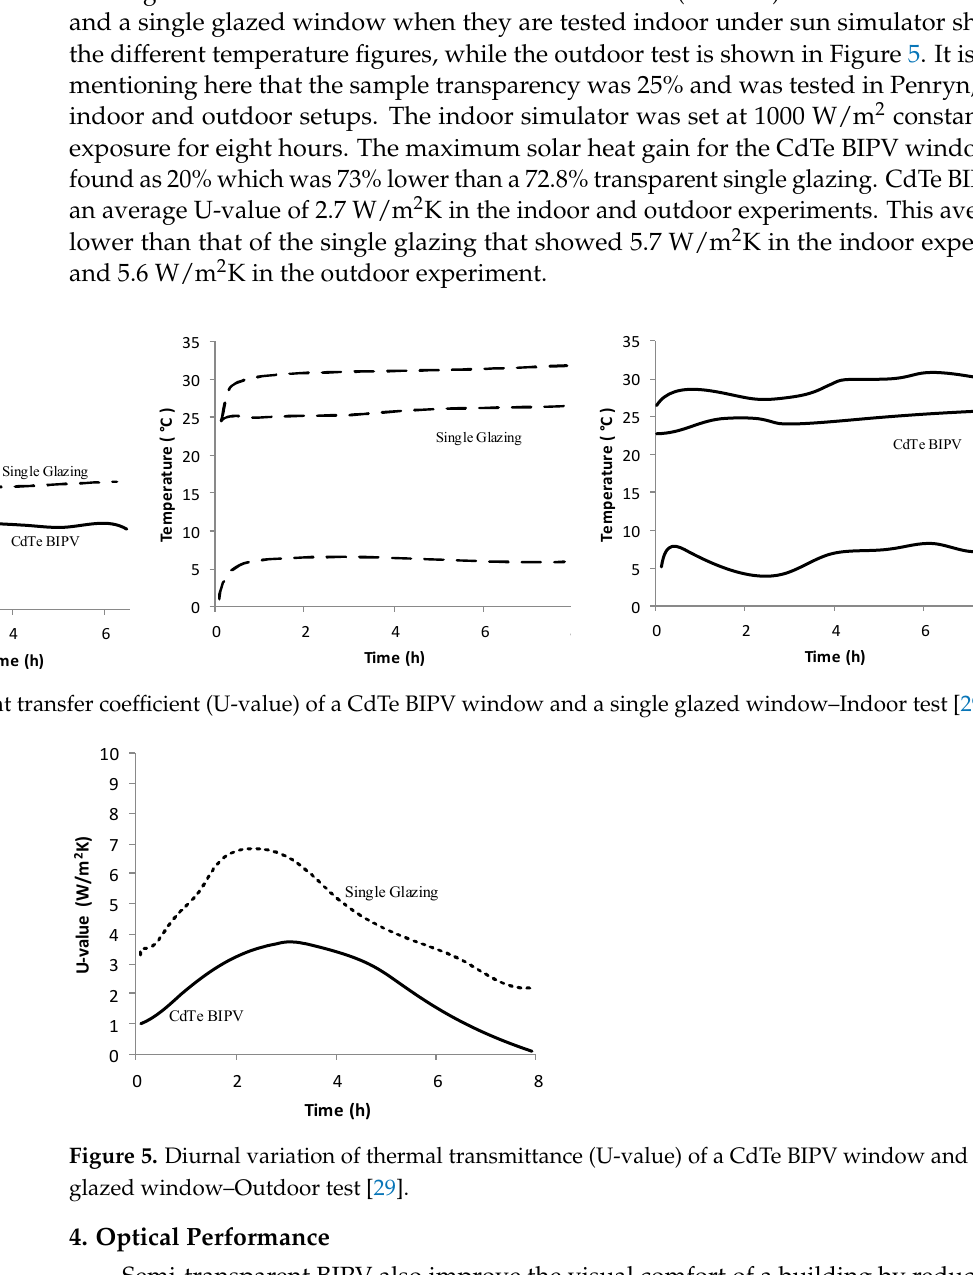
glazed window–Outdoor test